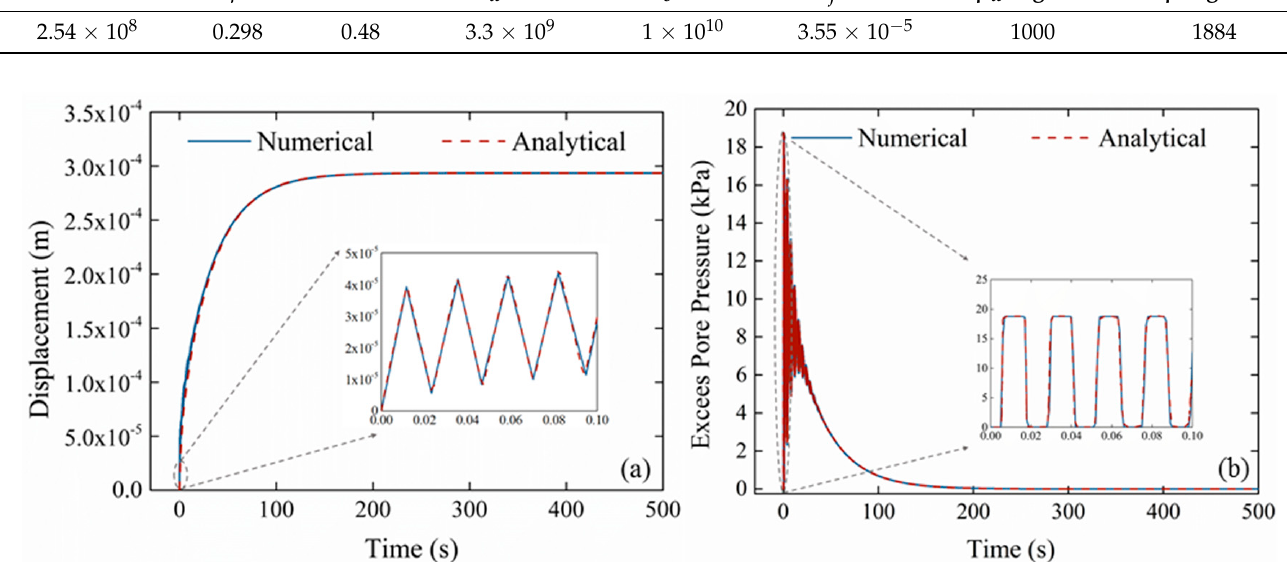
Figure 2. Comparison of numerical and analytical solutions for a 1D dynamic consolidation problem: ( a ) Vertical displace- ment at point 1; ( b ) Excess pore water pressure at point 2.